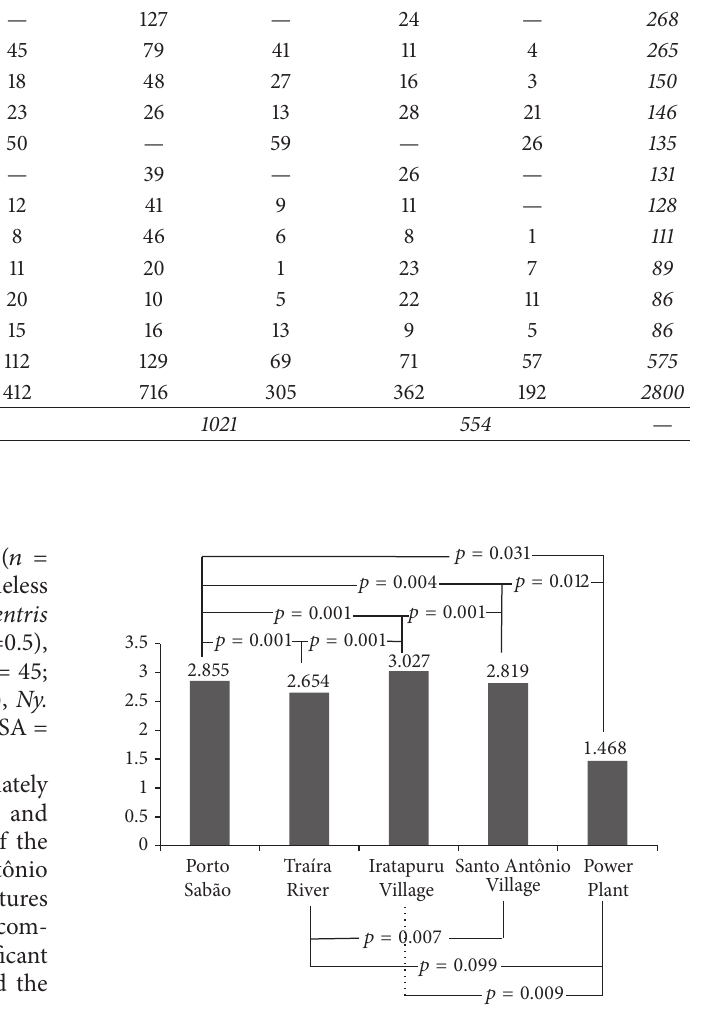
Figure 2: Comparison of Shannon diversity indexes for CDC- captured phlebotomines from the five surveyed locations in Santo Antˆonio do Jari hydroelectric system impacted area, between the states of Par´a and Amap´a, Brazil